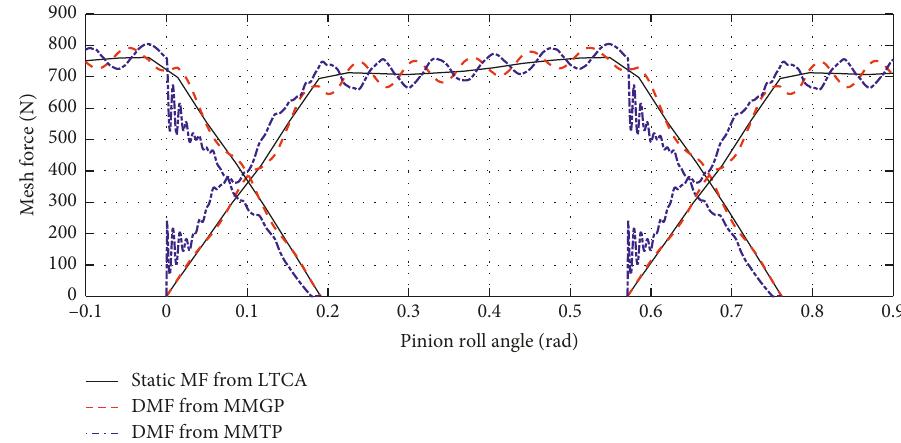
Figure 18: Time histories of DMF per tooth pair at the mesh frequency of 50Hz and 50Nm torque load.